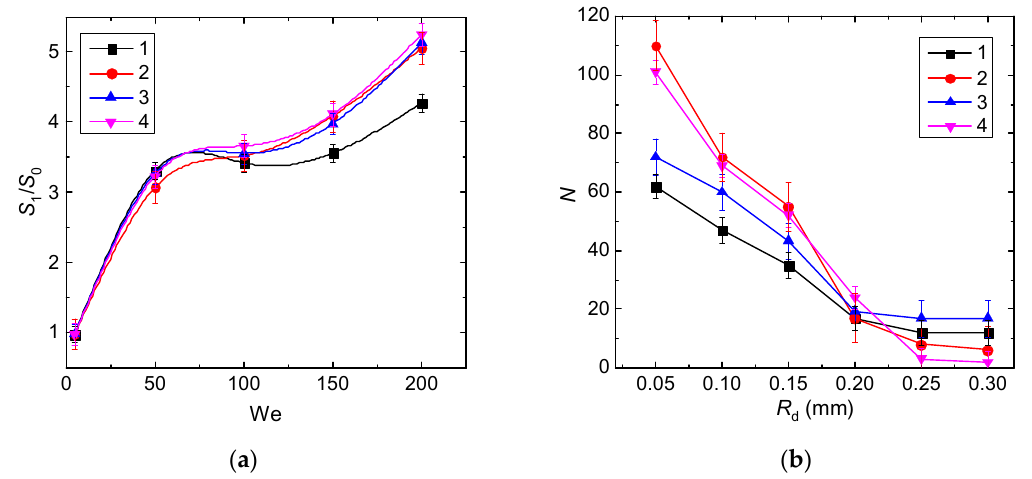
Figure 12. Growth of relative area of the liquid surface in droplet collisions ( a ) and typical (for We ≈ 150) size distributions of post-collision liquid fragments ( b ): 1, 2—water at 20 and 80 °C; 3, 4—slurry at 20 and 80 °C.